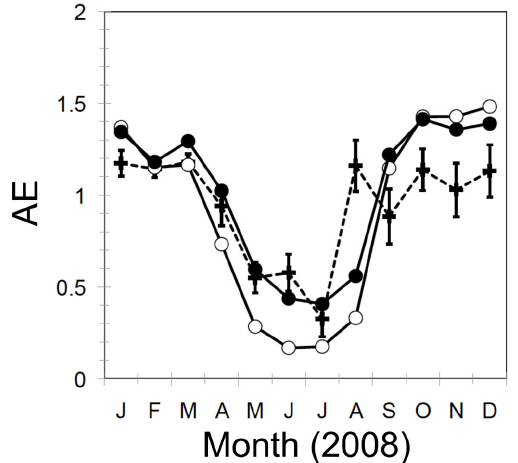
Fig. 6. Monthly variations in AE from two model simulations with the AC emissions (solid line with white circles), modified AC emis- sions (solid line with black circles) and skyradiometer observations (dashed line with crosses) for the year 2008.